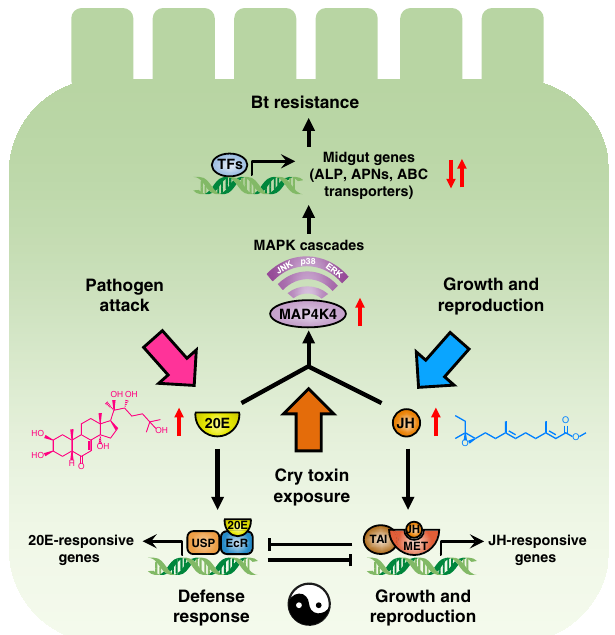
Fig. 9 Model for insect hormones-mediated growth-defense tradeoffs orchestrating Cry1Ac resistance in P. xylostella . The molecular basis of JH and 20E signaling pathways is highly conserved in different insects: they have antagonistic actions to control life-history traits including growth, development, reproduction, and immunity. Upon exposure of P. xylostella to Bt Cry1Ac toxin, in the midgut epithelial cells, we can speculate that JH/20E can bind to the respective heterodimeric receptor complex composed of Methoprene-tolerant (Met) and its partner Taiman (Tai) or ecdysone receptor (EcR) and Ultraspiracle (USP) to initiate the transcription of JH/ 20E-responsive genes. Meanwhile, increased levels of JH and 20E can activate the MAPK signaling cascades to trans -regulate differential expression of multiple midgut genes including four PxAPNs ( PxAPN1 , PxAPN3a , PxAPN5 , and PxAPN6 ), PxmALP , PxABCB1 , PxABCC1-3 , and PxABCG1 via manipulating unidenti fi ed transcription factors (TFs) 70 , which fi nally results in high-level Bt resistance without growth penalty in P. xylostella